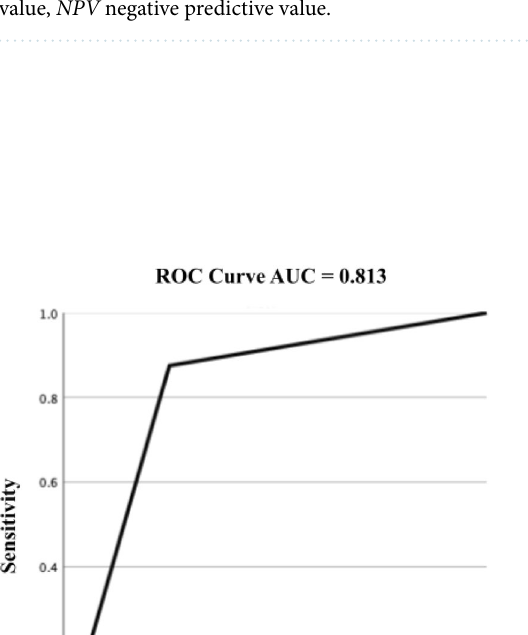
Table 1. Performance of the machine learning model for dye eye disease diagnosis. PPV positive predictive value, NPV negative predictive value.